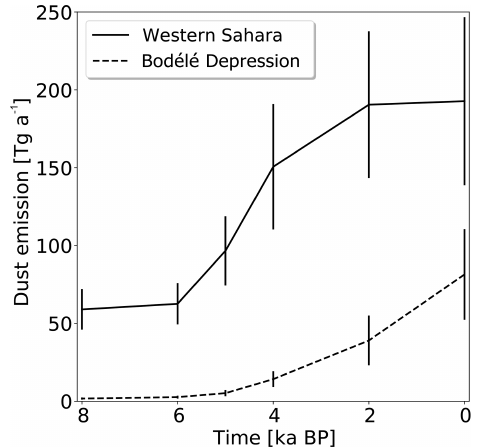
Figure 7. Simulated dust emissions from the western Sahara (15 ◦ W–2 ◦ E, 18–29 ◦ N; solid) and from an area including the Bodélé Depression (14–22 ◦ E, 12–18 ◦ N; dashed). Both areas are shown in Fig. 6.